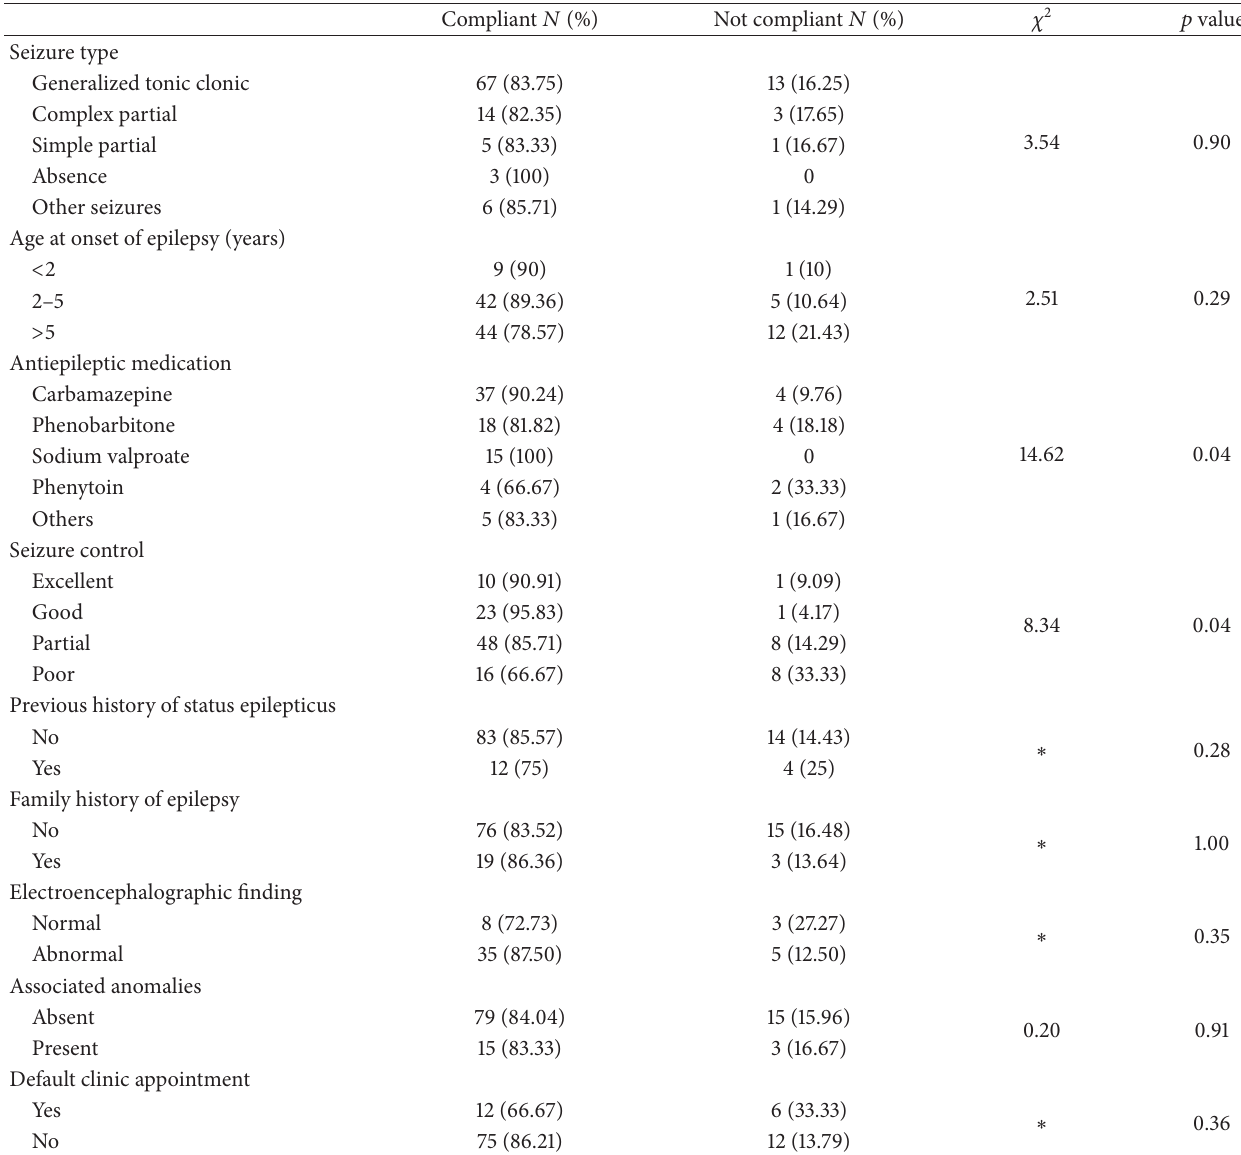
Table 5: The association between noncompliance to medication and seizure related